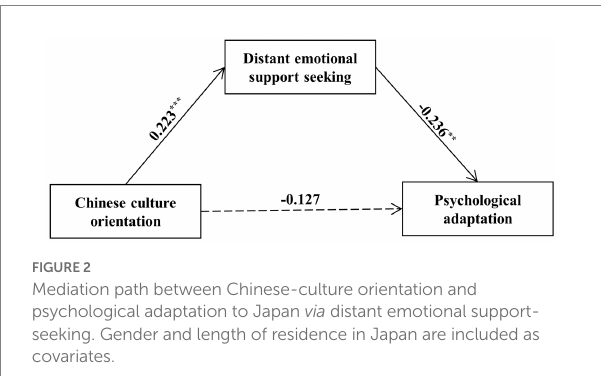
FIGURE 2 Mediation path between Chinese-culture orientation and psychological adaptation to Japan via distant emotional support- seeking. Gender and length of residence in Japan are included as